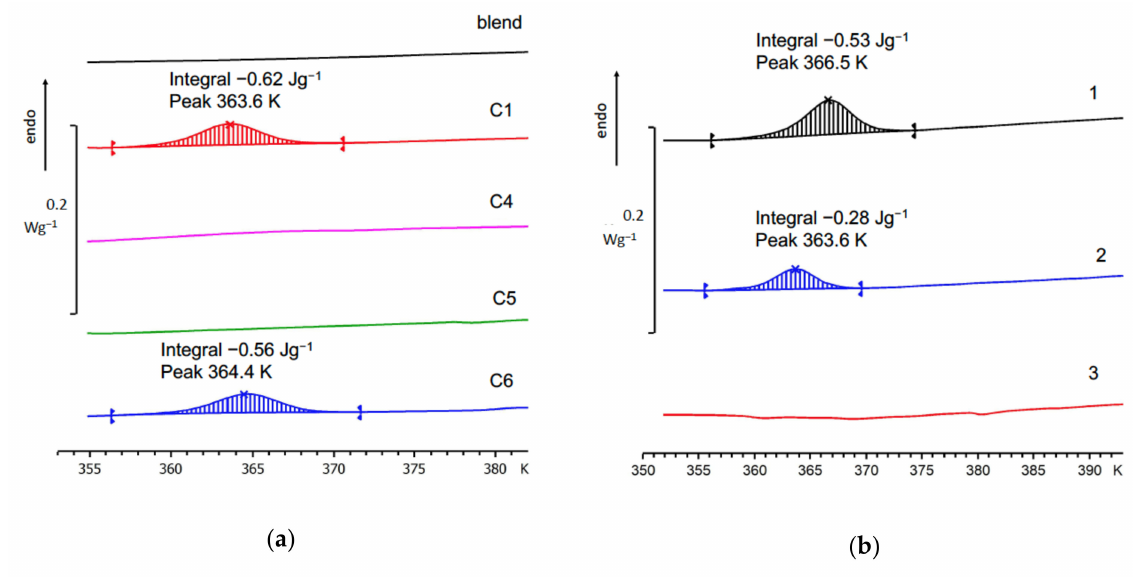
Figure 8. Endothermic effect on the DSC heating curves of ( a ) NB–CDD copolymers and PNB/PCDD blend annealed at 5 K above their full amorphization temperatures, T end , for 30 min and ( b ) NB–CDD C1 copolymer annealed for (1) 1 h and (2) 5 min at 355 K and (3) without annealing. The polymers were preheated up to 383 K to erase the thermal